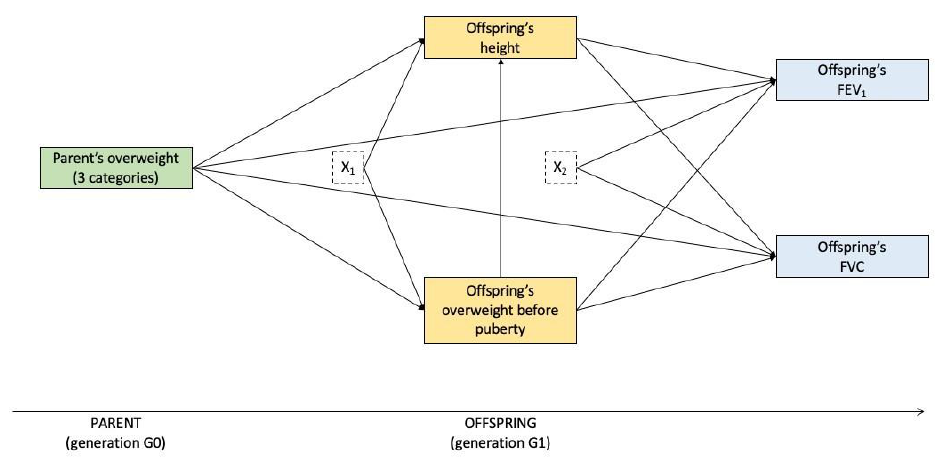
Figure 3. Graphical representation of the mediation model for FEV 1 and FVC in sons or daughters within the paternal or maternal lines (model one). The green box represents the exposure of interest, the yellow boxes the mediators and the blue boxes the outcomes. The dotted boxes represent the set of potential confounders and adjusting variables of the mediators (X 1 : parents’ education level) and of the outcomes (X 2 : parents’ education level and offspring’s age and their own smoking history).